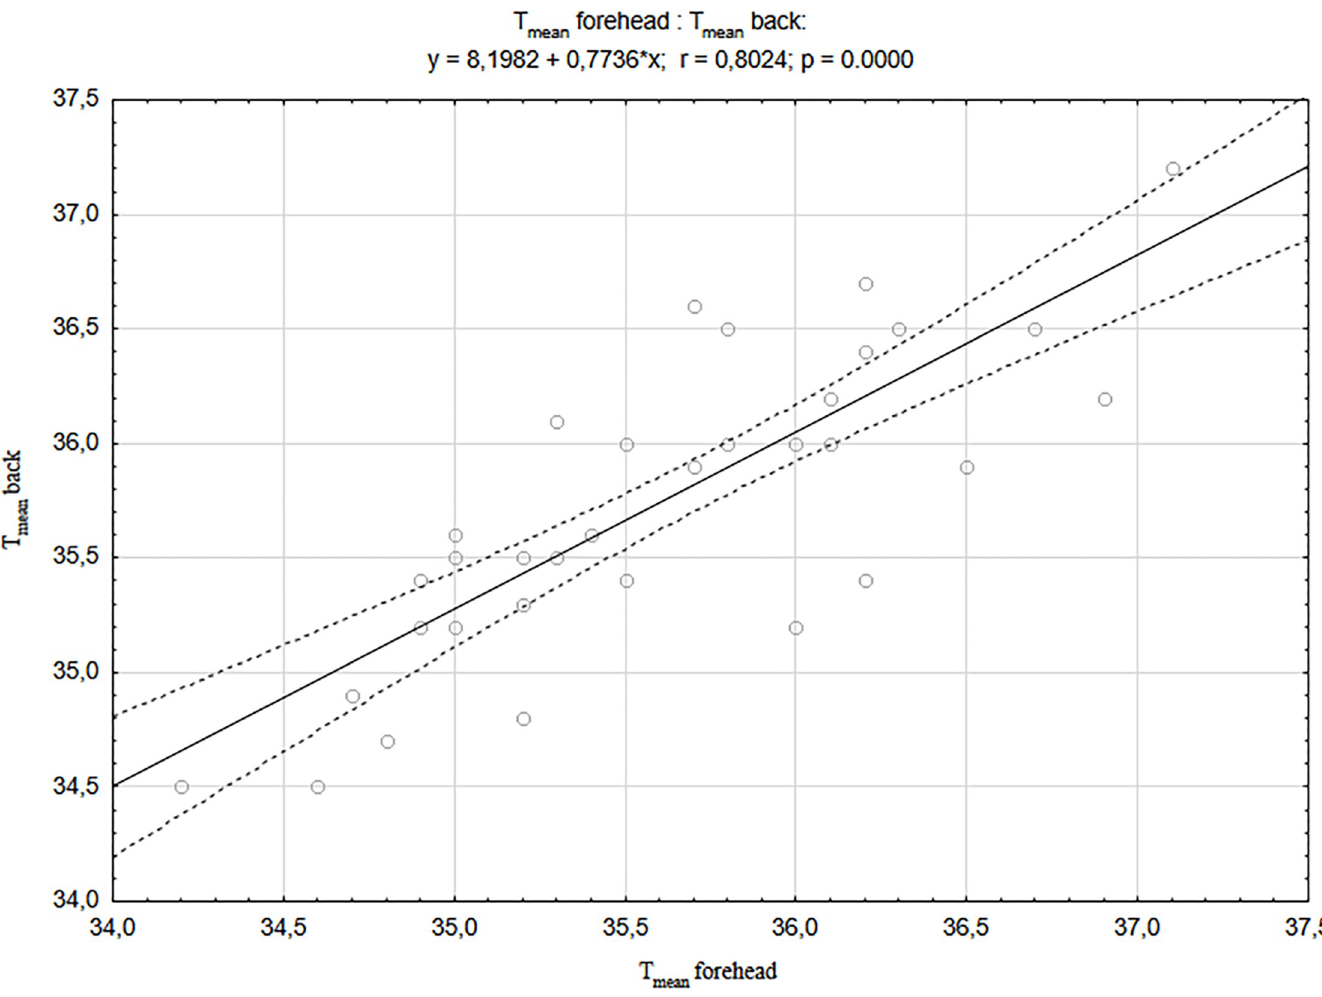
Fig 2. A correlation between T mean forehead and T mean back in newborns born by